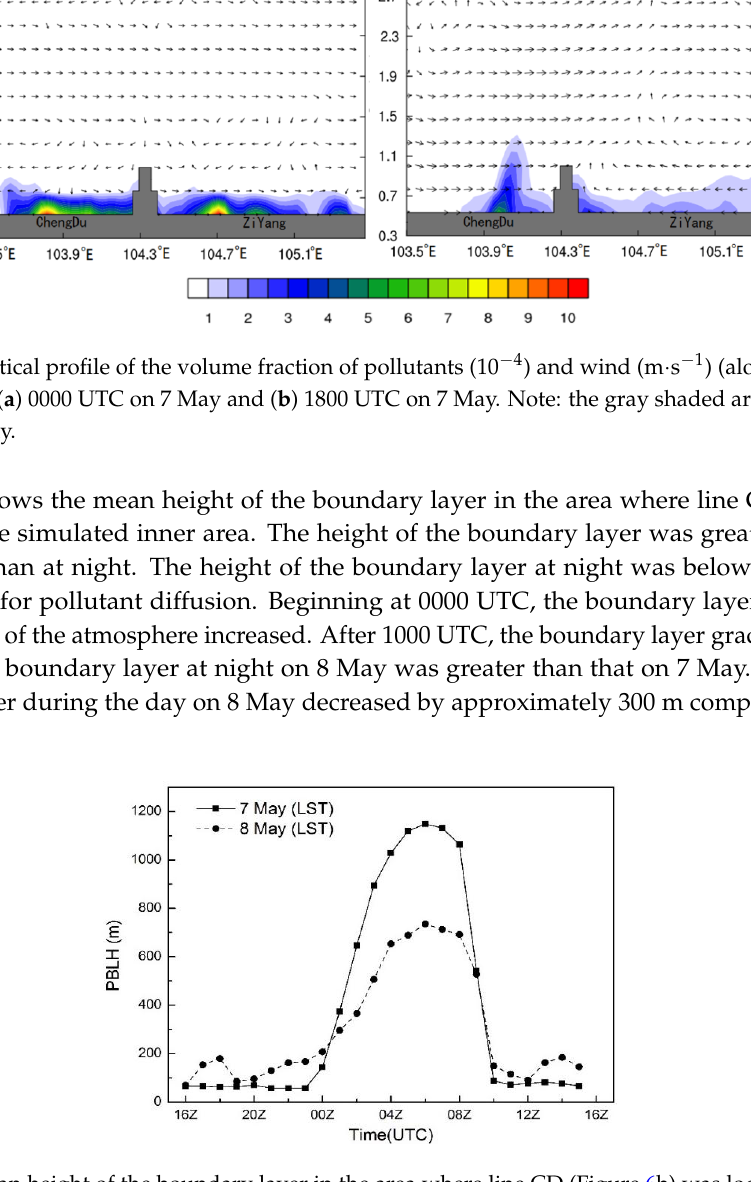
Figure 13. Mean height of the boundary layer in the area where line CD (Figure 6b) was located in the simulated inner area.